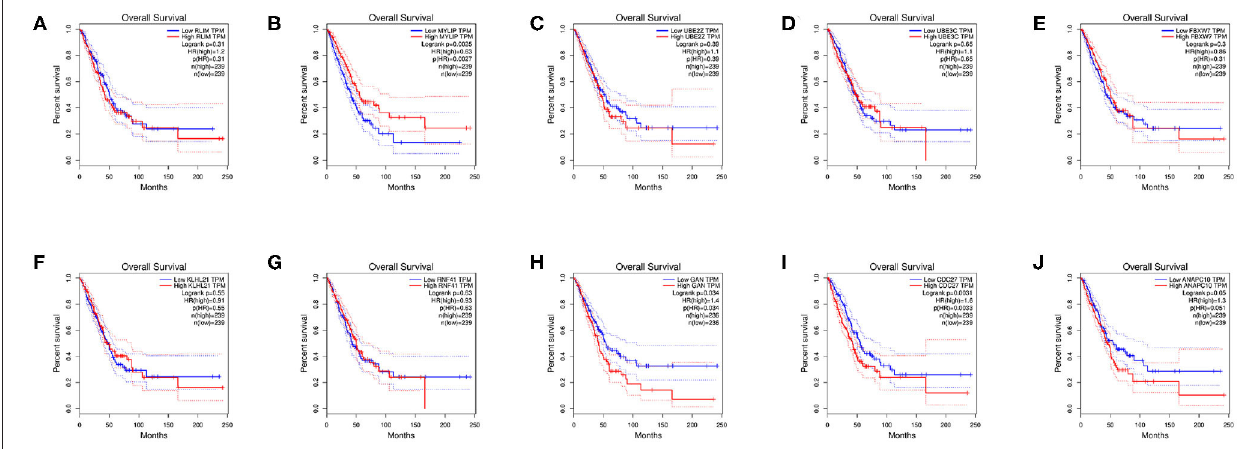
FIGURE 8 | Survival analysis of hub genes, (A) RLIM, (B) MYLIP, (C) UBE2Z, (D) UBE3C, (E) FBXW7, (F) KLHL21, (G) RNF41, (H) GAN, (I) CDC27, (J)